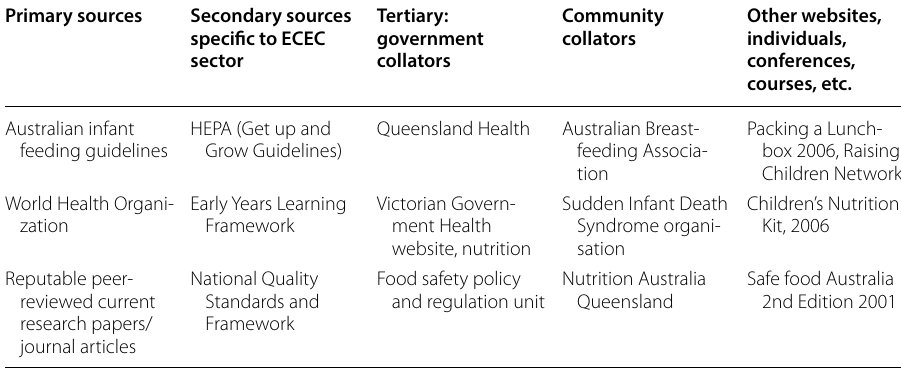
Table 5 Infant feeding policy source documents (examples) Primary